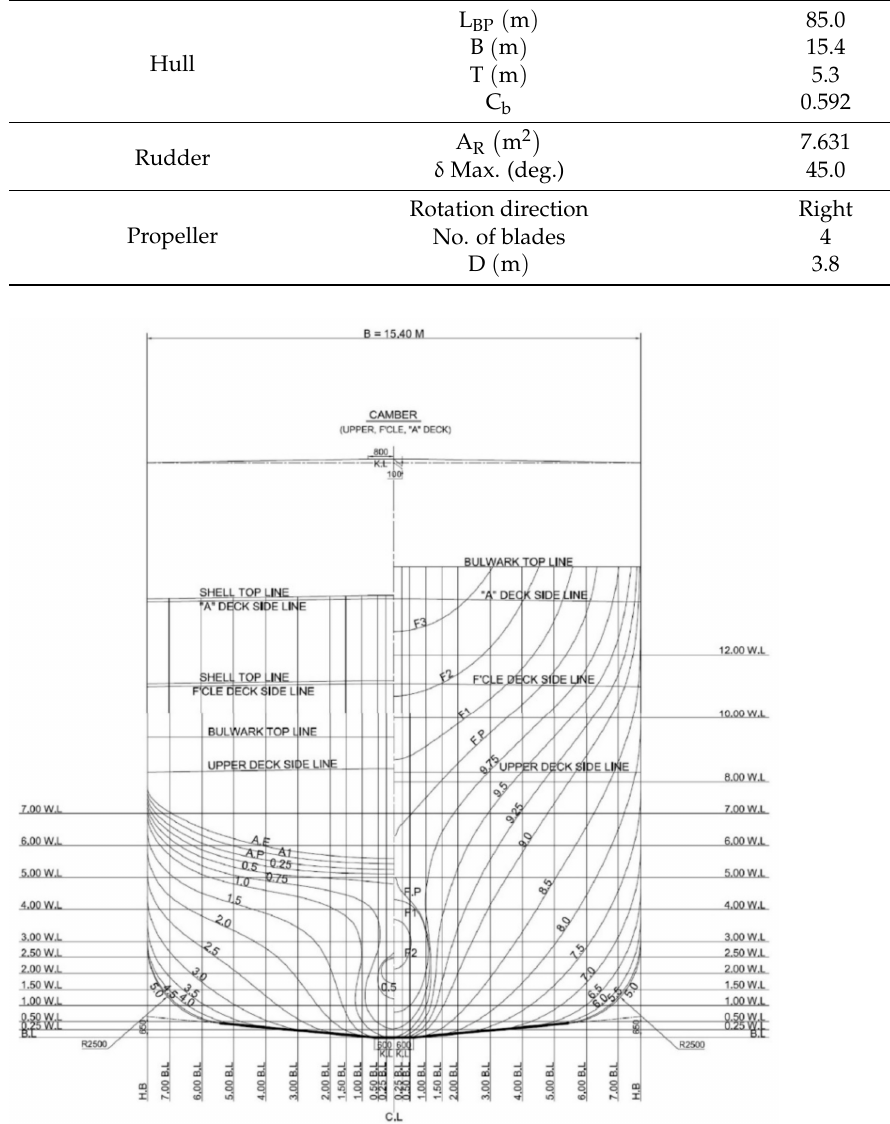
Figure 6. Body plan of target fishing